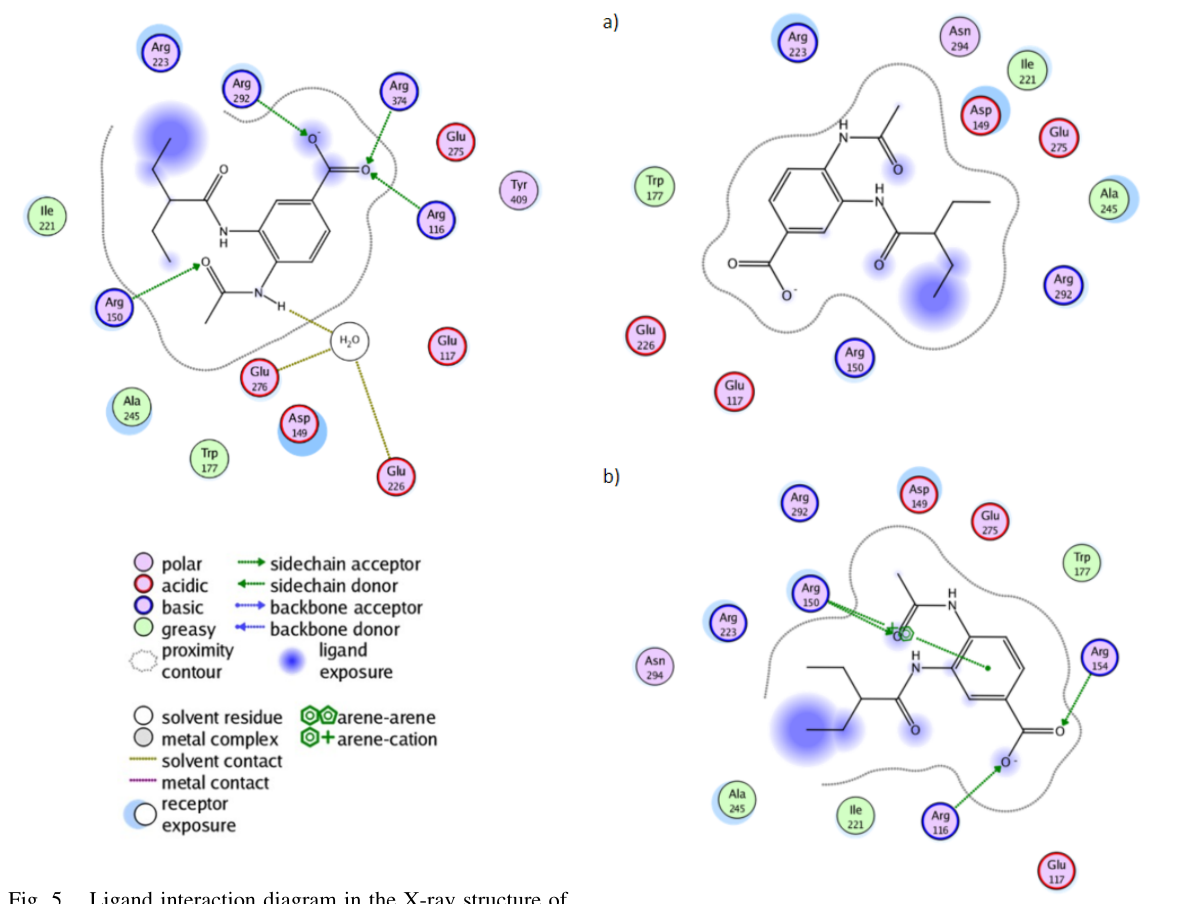
Fig. 6. Protein-ligand interactions identified in NA: a) after docking; b) after Case 1 minimization in